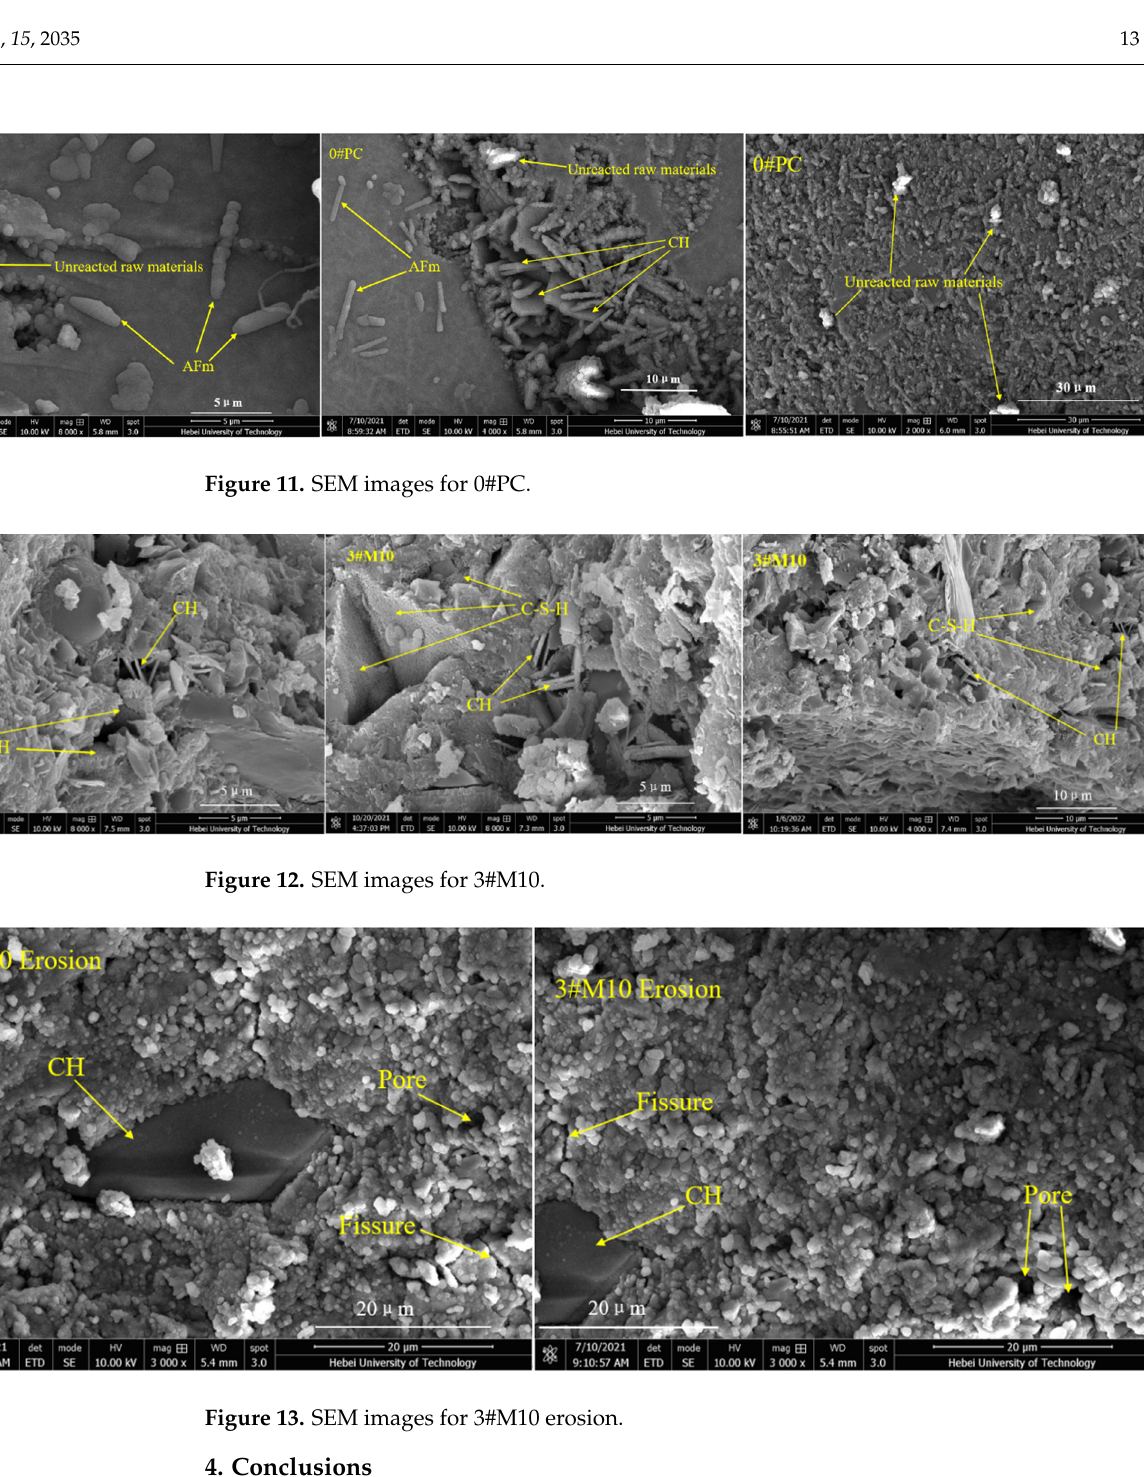
Figure 13. SEM images for 3#M10 erosion; ( a ) and ( b ) are SEM images of 3#M10 erosion.